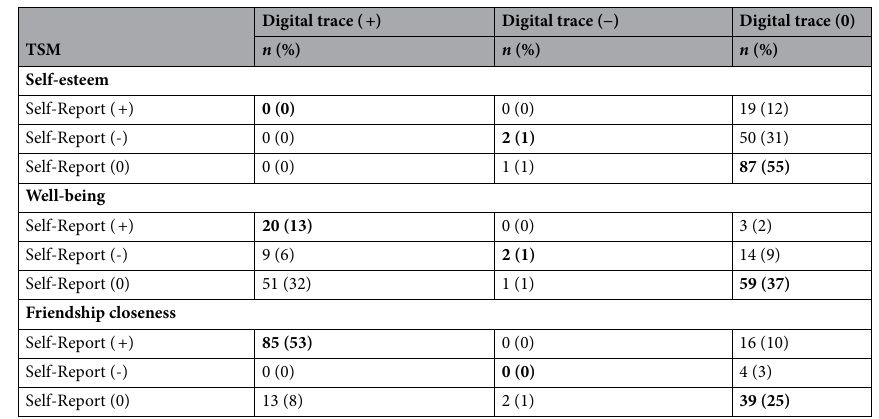
Table 3. Overlap of Person-Specific Effects of the Self-Reported and Digital Trace Measure of Time Spent on Social Media (TSM) on Self-Esteem, Well-Being, and Friendship Closeness. N = 159. + = positive effect; – = negative effect; 0 = no effect. The bold n s and percentages on the diagonals indicate positive, negative, and no to very small effects of TSM that overlap across self-reported and digital trace measures. For example, as for self-esteem, 0 out of 159 adolescents experienced a positive effect of TSM according to both self-reported and digital trace measures, while 2 out of 159 adolescents (1%) experienced a negative effect, and 87 out of 159 adolescents (55%) a not to very small effect according to both the self-reported and digital trace measures of TSM Therefore, in total, the person-specific effects of self-reported and digital trace measures of TSM on self- esteem overlapped for 89 out of 159 adolescents (56%). As there are no guidelines to interpret the comparative predictive validity on a person-specific level, we focused on the overlap of the person-specific effects of the self- reported and digital trace measure of TSM on psychosocial